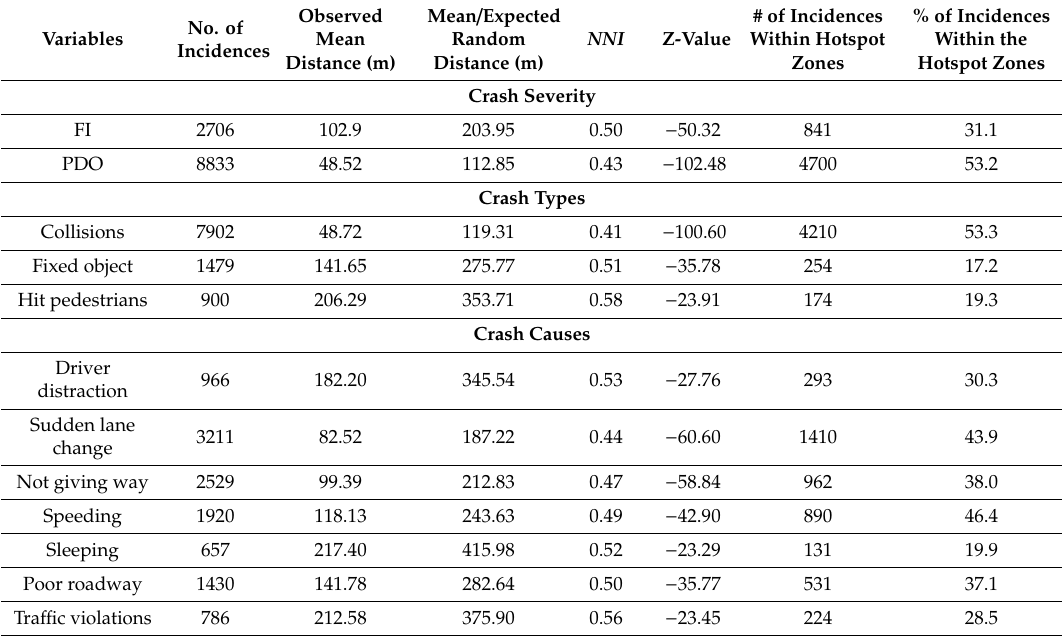
Table 1. Nearest neighbor index ( NNI ) values and the number of incidences within each hotspot